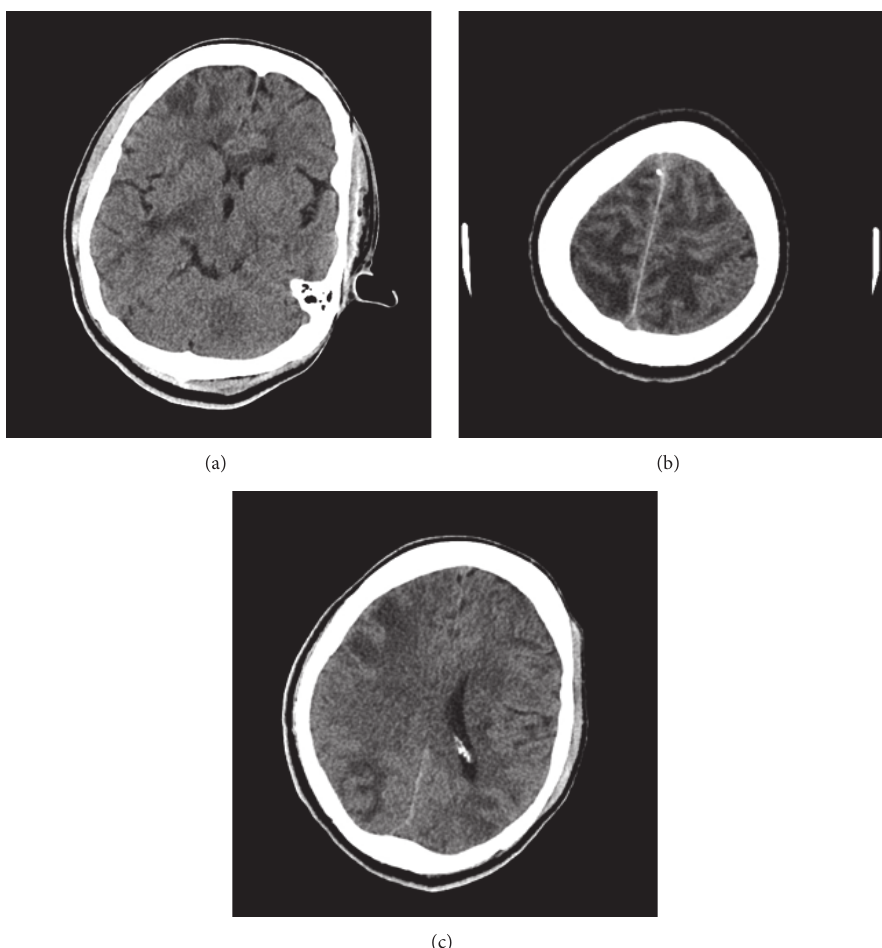
Figure 1: CT Head-Axial images demonstrate extensive multifocal areas of white matter